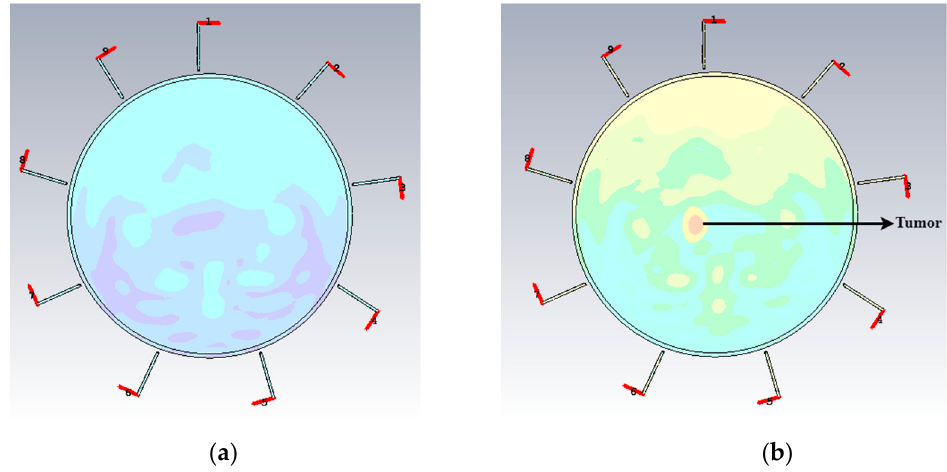
Figure 12. Images of ( a ) without and ( b ) with one tumor inside the breast phantom.